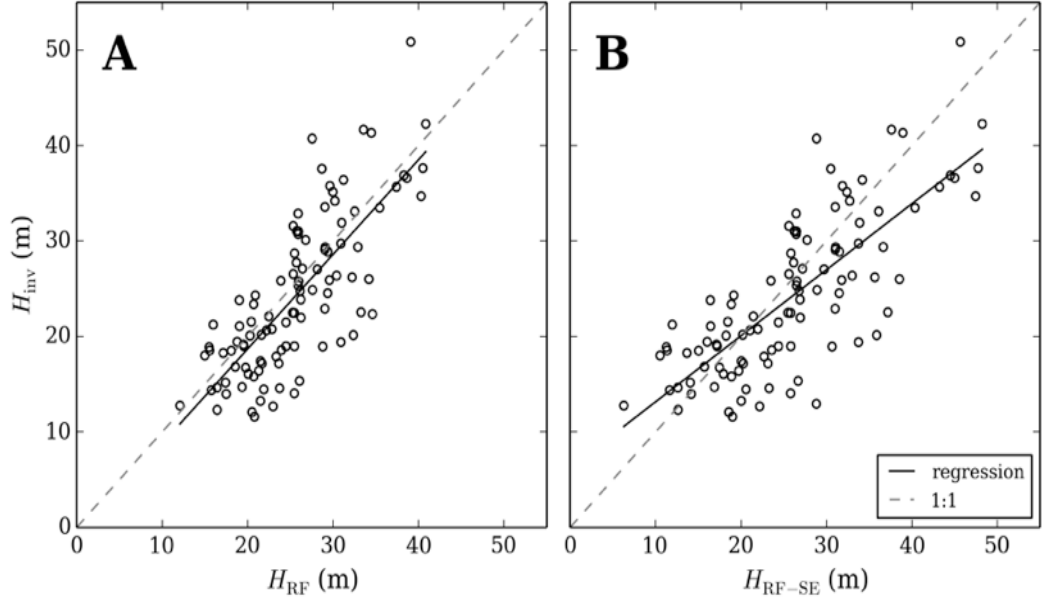
Figure 7. A comparison of inventory measured canopy height ( H inv ) with random forest ( H RF ) ( A ) and random forest corrected for systematic error ( H RF-SE ) ( B ) estimated canopy height, at 108 forest inventory plots.